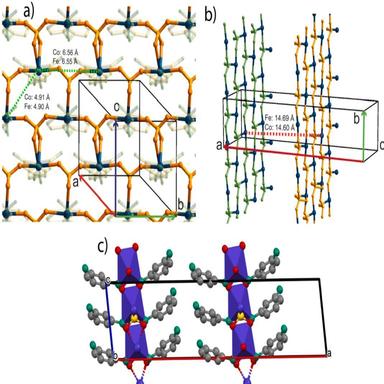
Compounds 2 and 3, inorganic layers. Colors indicate: S-yellow, Co-blue, O-orange. Diamine molecules are a) transparent green; b) removed for clarity; A general packing of the crystal structure is presented in c).